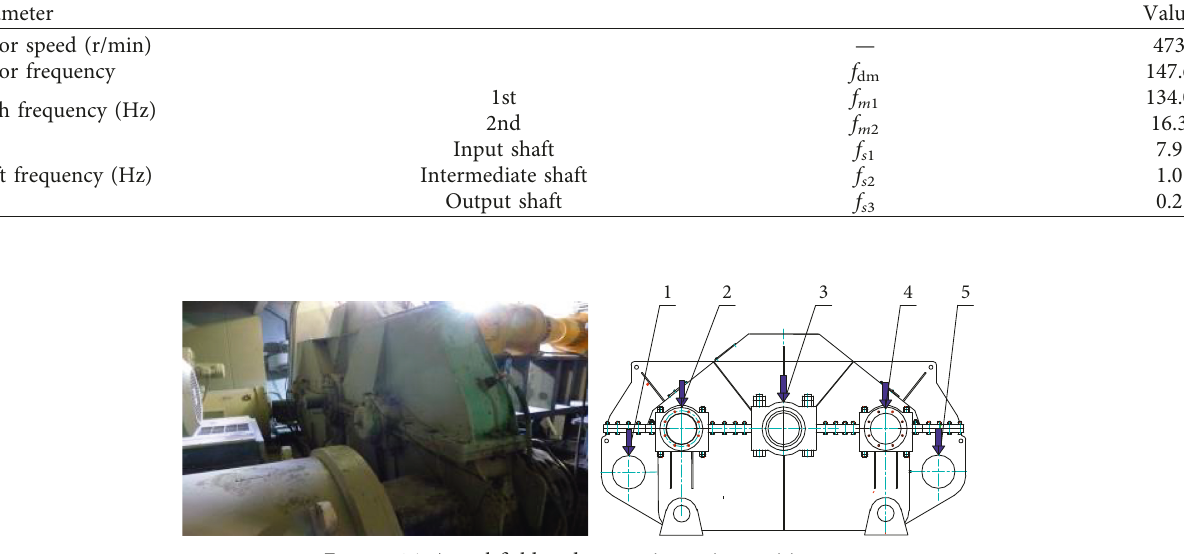
Figure 16: Actual field and measuring point